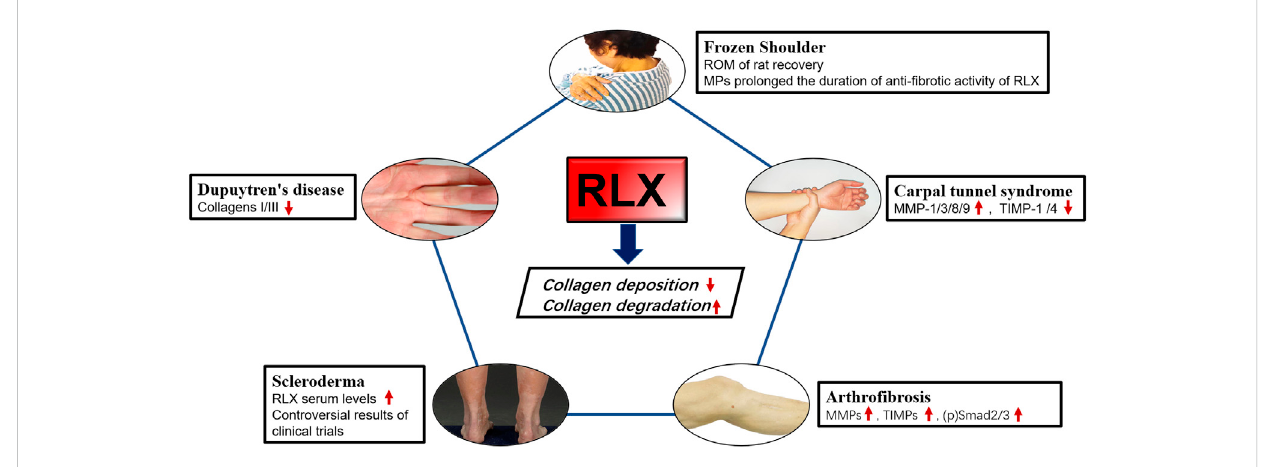
FIGURE 3 The effects of RLX in fi brotic diseases of the ligaments. Image sources of Dupuytren ’ s disease (Karbowiak et al., 2021) and Scleroderma (Orteu et al., 2020) are from